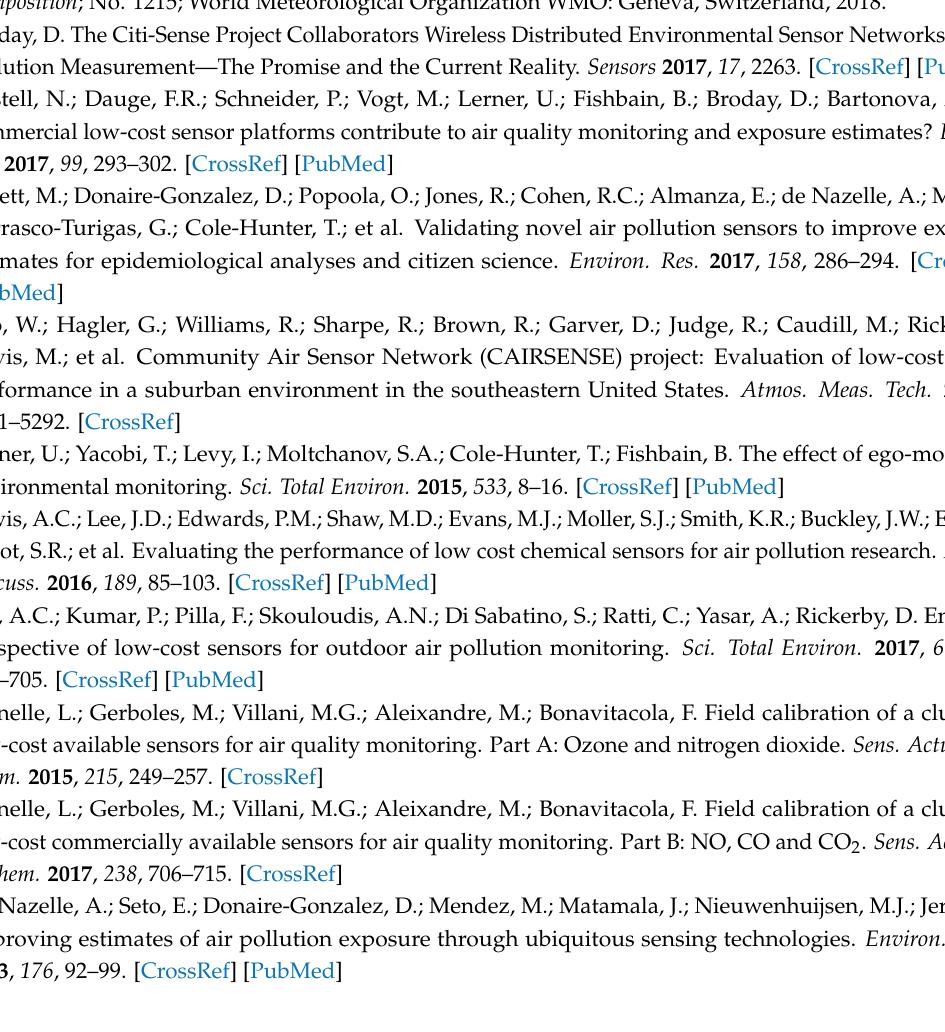
s1, Table S1: Coding round 1; Table S2: Coding round 2; Table S3: Additional coding iterations for “REC” in R1; Table S4: Additional coding iterations for “REC” in R2; Table S5: Statistics of “REC”; Table S6: Code frequency statistics; Table S7: Volunteers